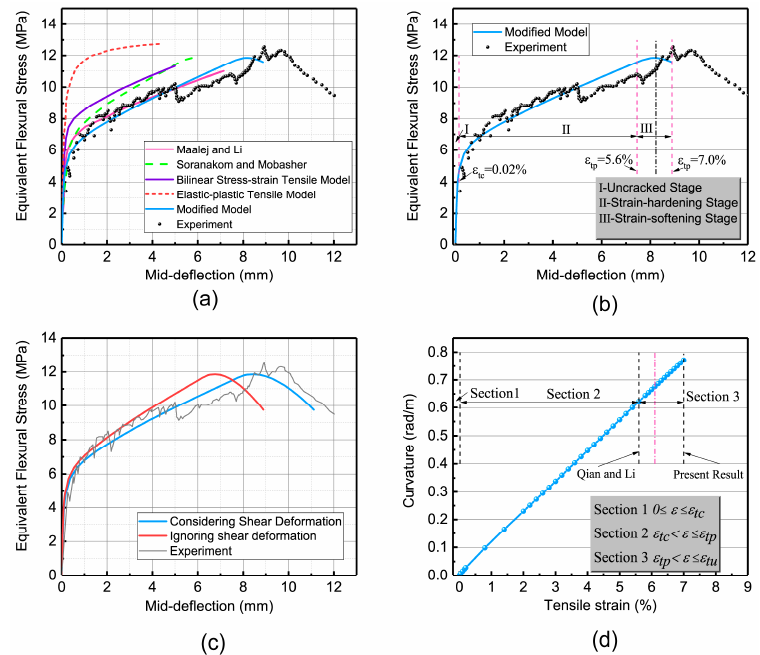
Figure 12. The simulation of a SHCC: ( a ) simulated and observed equivalent flexural stress vs. deflection responses; ( b ) predicted curve between moment and tensile strain; ( c ) simulated and observed equivalent flexural stress vs. deflection responses based on the shear effect; and ( d ) computed curvature vs. tensile strain.